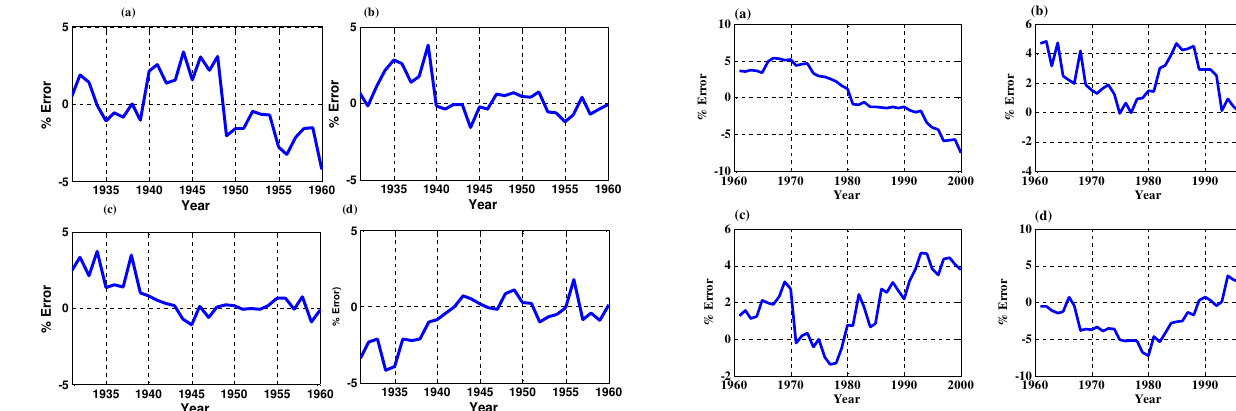
Fig. (15). Error Distribution Utilizing Ensemble Neural Network for (a) October (b) April (c) May (d) July.